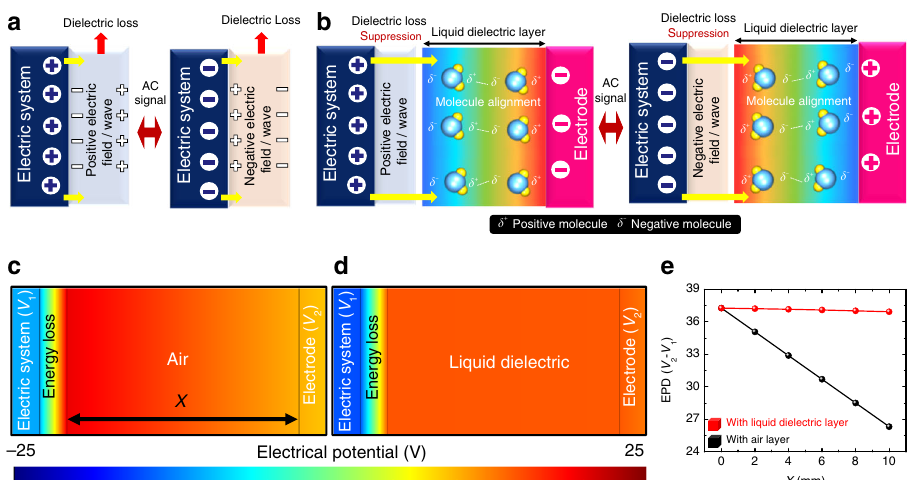
Fig. 2 ELRG is available with a liquid dielectric polarization. a The existence of a liquid dielectric layer determines the energy transfer process. Electric/ electronics systems dissipate electromagnetic energy without a liquid dielectric layer. b Liquid dielectric layer scavenges the dissipated electromagnetic energy. c Electrostatic simulation resultants. Insets show the degree of generated electric potential with air layer. d The degree of generated electric potential with liquid dielectric layer. e Electrostatic potential differences between electric system and electrode. EPD is more stable when liquid dielectric layer is integrated